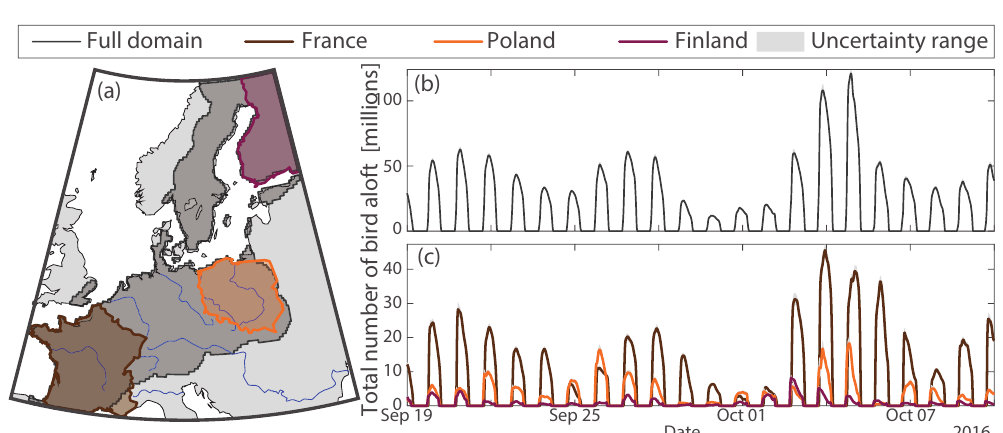
Figure 7. Averaged time series of birds in migration and their associated uncertainty ranges (10–90 quantiles) over (b) the whole domain, and (c) France, Poland and Finland. (a) illustrates the location and size of the three